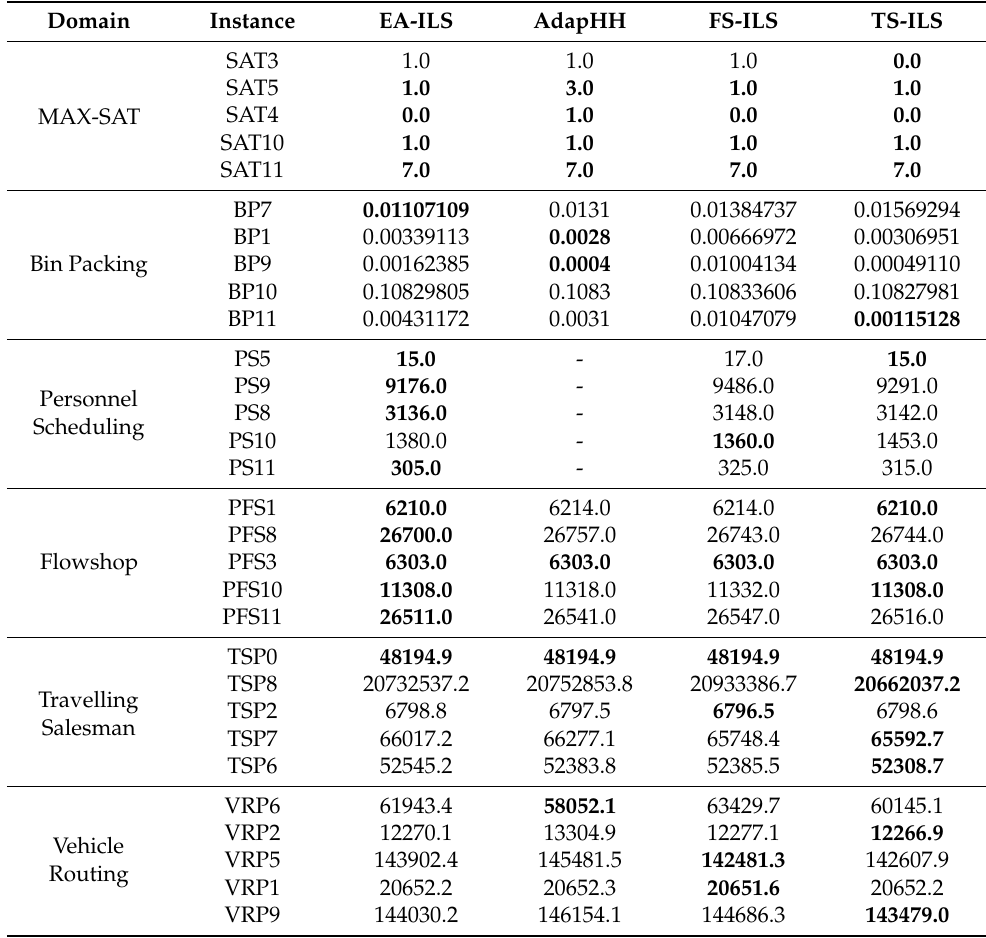
Table 10. Best ofvs Obtained by EA-ILS against three state-of-the-art